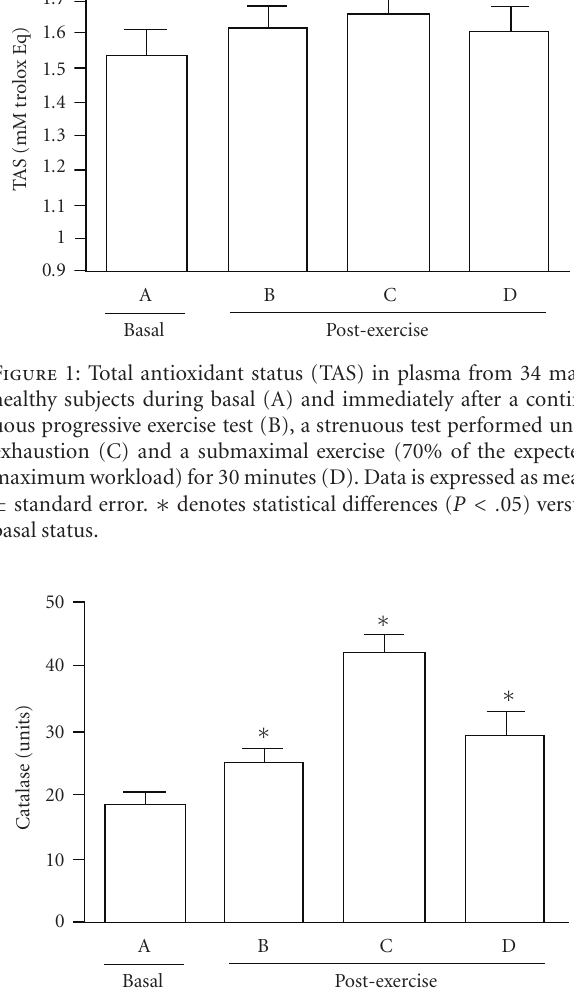
Figure 2: Catalase (CAT) activity in plasma from 34 male healthy subjects during basal (A) and immediately after exercise (B, C, and D). Data is expressed as mean ± standard error. ∗ denotes statistical di ff erences ( P < . 05) versus